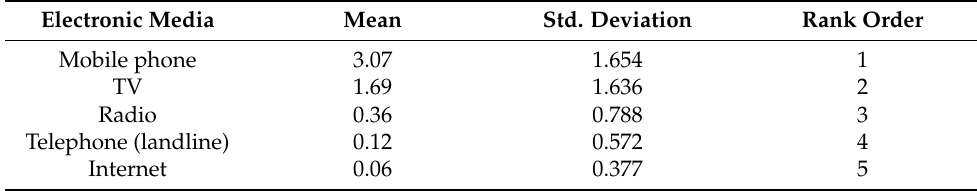
Table 1. Usefulness of electronic media (EM) as a source of information among dairy farmers.